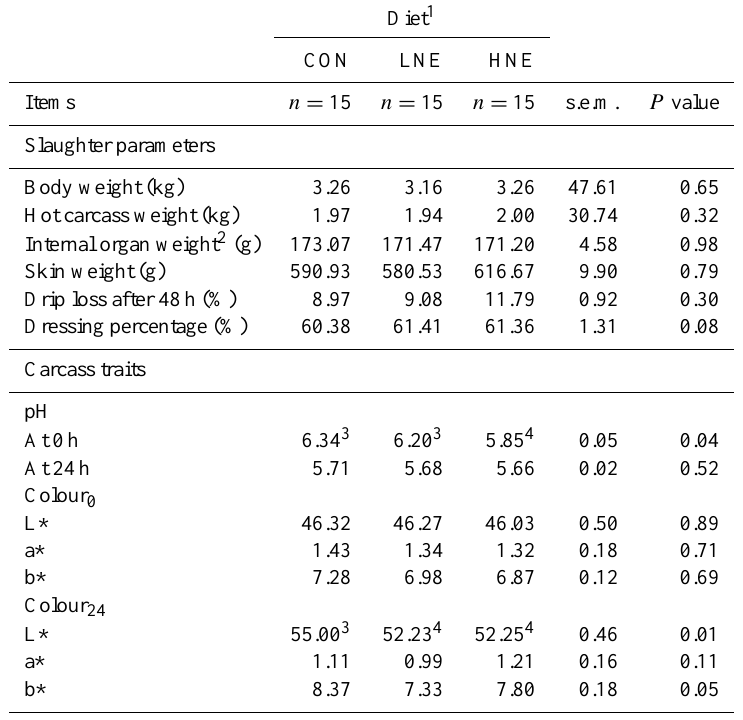
1 Diet: control group (CON); low natural extract (LNE); high natural extract (HNE). 2 Internal organs: heart, liver, spleen, lung. 3 , 4 Values within a row with different superscripts differ significantly at